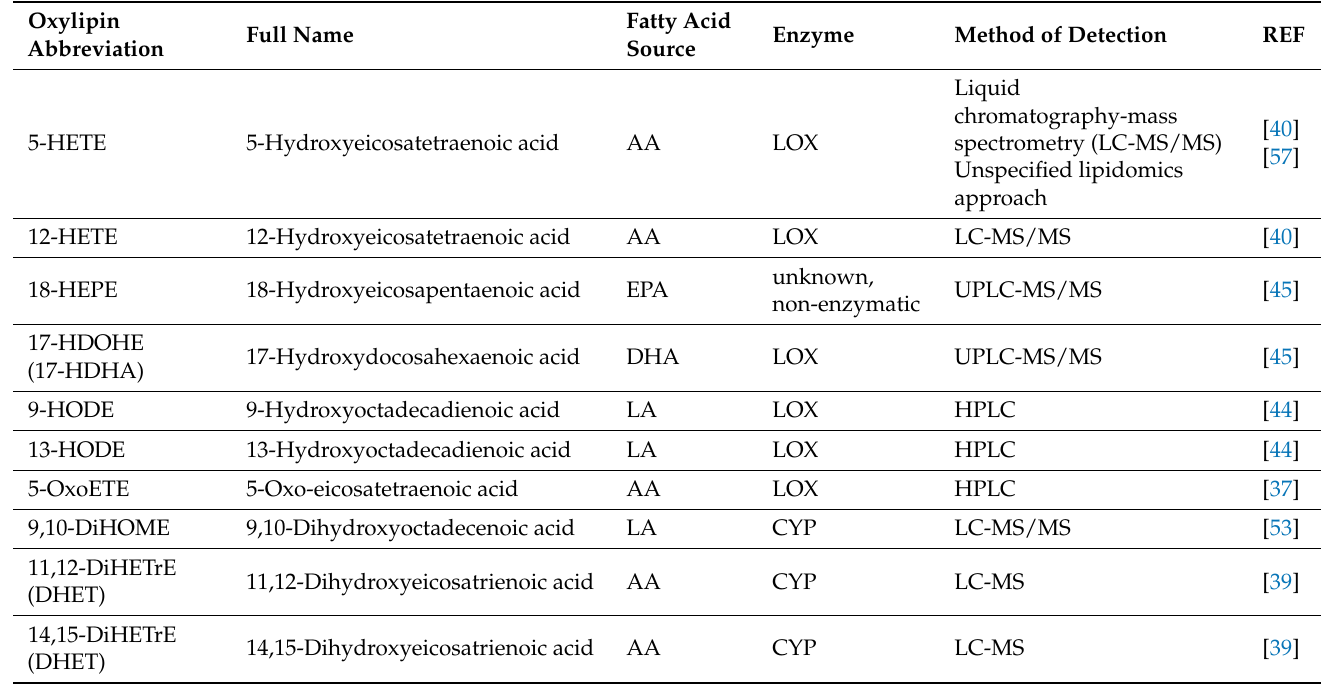
Table 1. Methods of eicosanoid